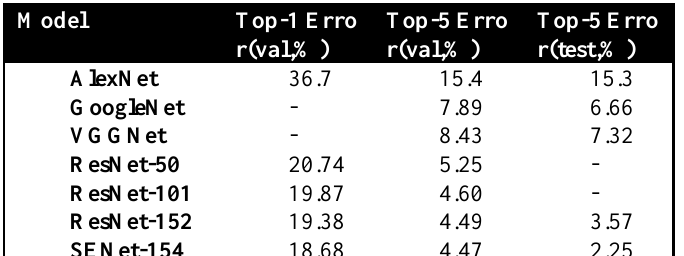
Table 1. Error rate comparison